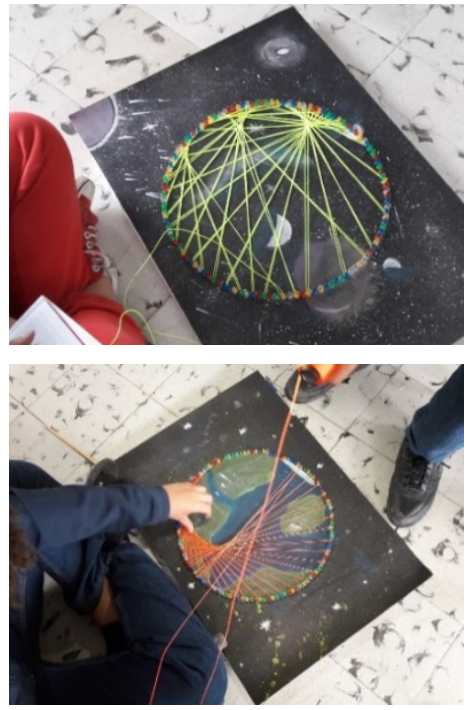
Figure 5. Centrifugal force as an artistic method. In the upper image, the assembly of the device through which the centrifugal force could be generated can be seen. In the images below, results obtained through “centrifugal art” are displayed.